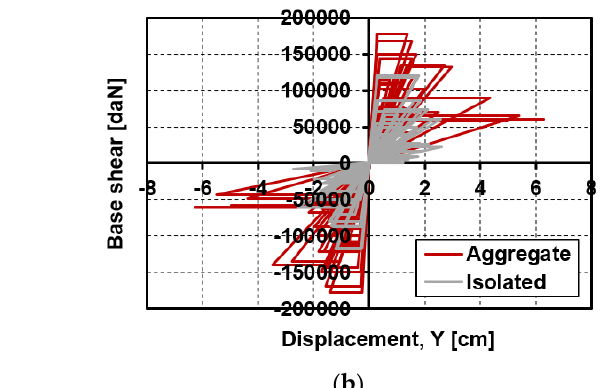
Figure 6. The macro-element models of the investigated SUs in the clustered conditions ( pink ) and the adjacent buildings ( brown ).